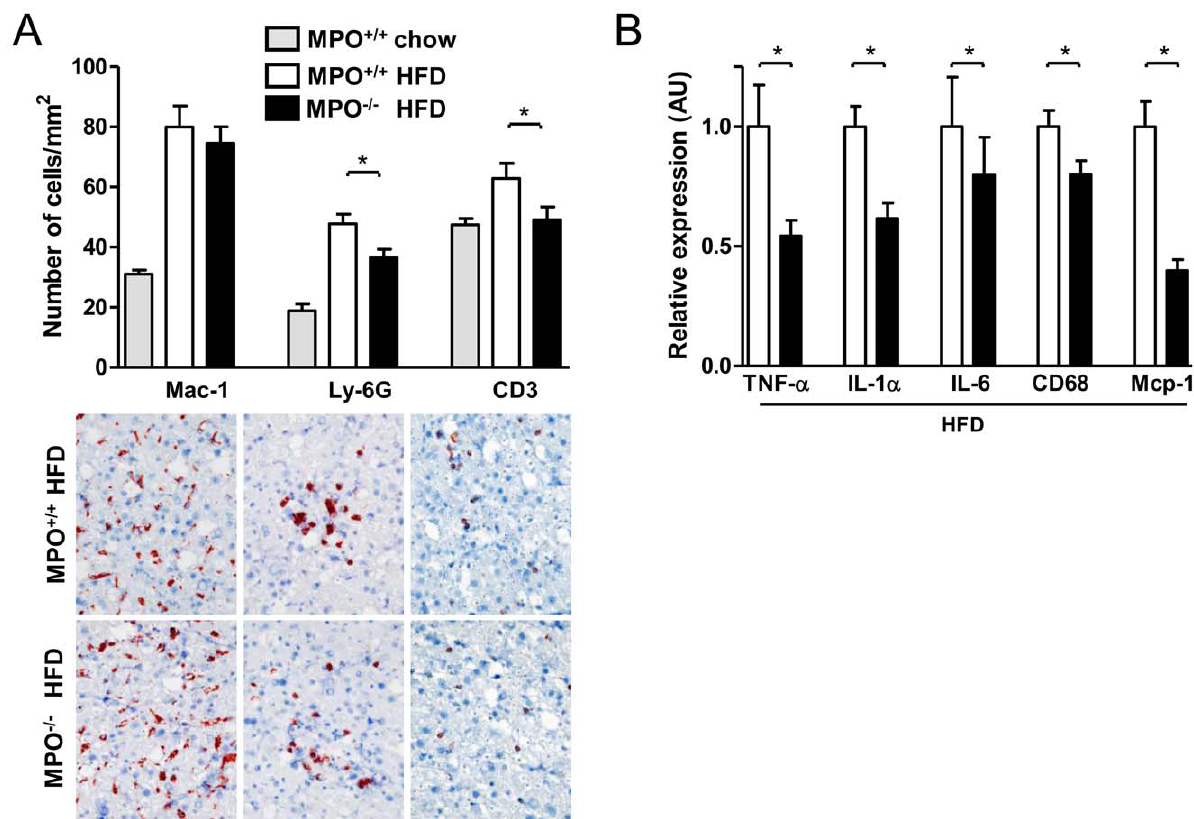
Figure 5. General reduction of diet-induced hepatic inflammation in LDLR 2 / 2 / MPO 2 / 2 tp mice. A) Significantly lower number of hepatic Ly- 6G + neutrophils and CD3 + T-lymphocytes in LDLR 2 / 2 / MPO 2 / 2 tp mice as compared with LDLR 2 / 2 / MPO + / + tp mice after 8 weeks of high-fat feeding (Ly- 6G: 36.7 6 2.6 vs. 47.8 6 3.1 cells/mm 2 , p=0.03; CD3: 49.1 6 4.2 vs. 62.9 6 5.0 cells/mm 2 , p=0.04). Pictures represent examples of the stainings (200 6 magnification). B) Hepatic pro-inflammatory cytokine/chemokine expression is substantially reduced in LDLR 2 / 2 / MPO 2 / 2 tp mice after 8 weeks high- fat diet (TNF- a 1.8-fold, p=0.03, IL-1 a 1.6-fold, p , 0.01, IL-6 1.3-fold, p=0.67, Mcp-1 2.5-fold, p , 0.01), in parallel with a reduction of CD68 expression (1.3-fold, p , 0.05).